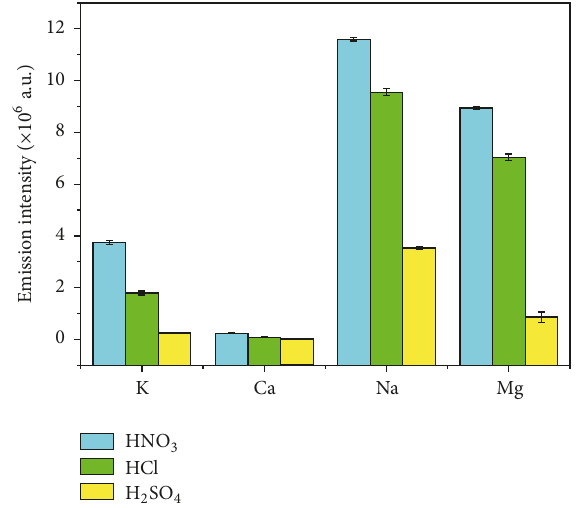
Figure 6: Effect of the supporting electrolyte (electrolytes: 5 mgL −1 K, Ca, Na, and Mg solution adjusted to pH = 1.0 by support acid, discharge voltage: 650 V, flow rate: 3 mLmin −1 , interelectrode gap: 2 mm, and capillary diameter: 1mm).